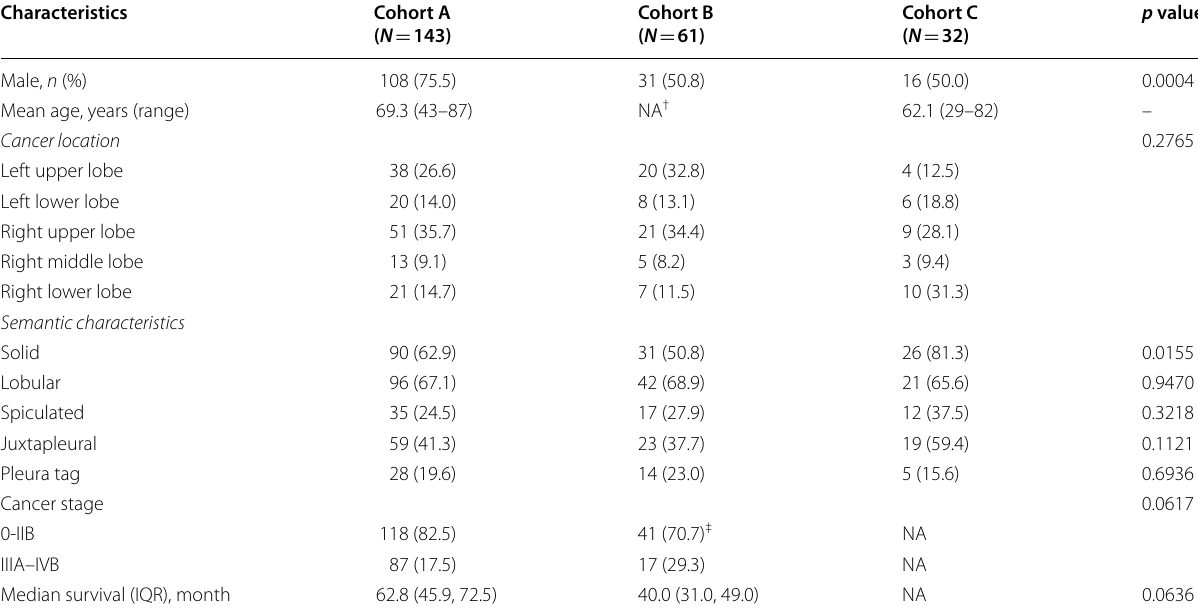
Table 1 Characteristics of lung cancer